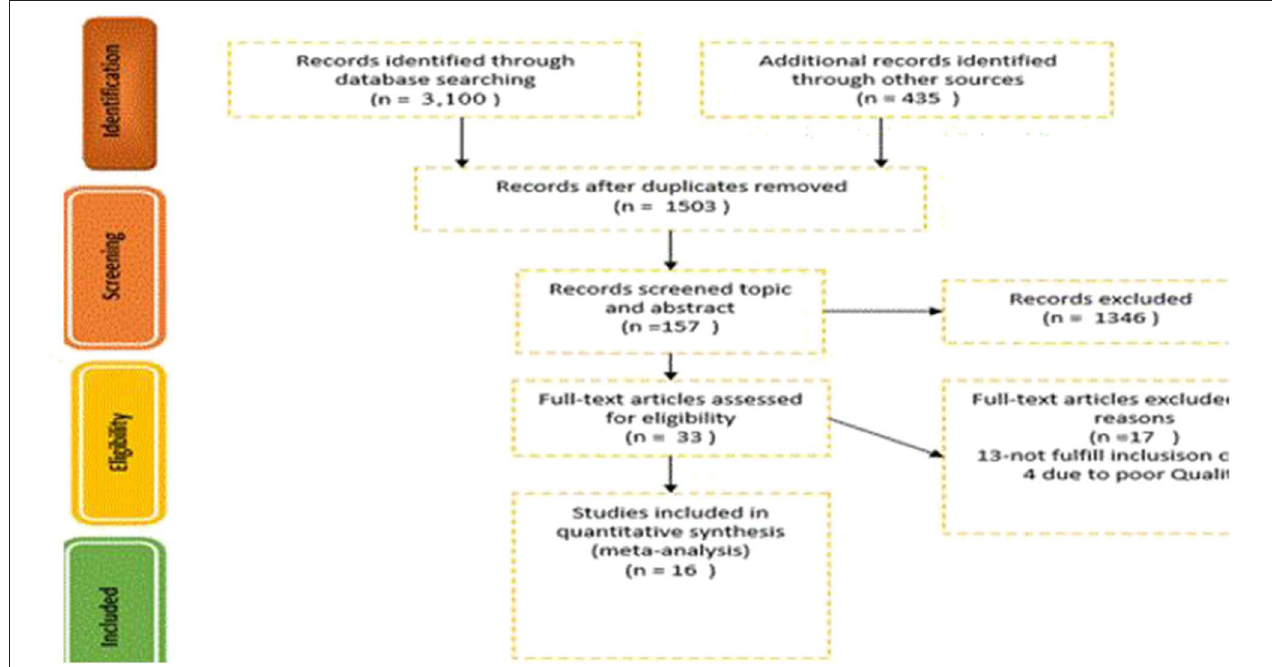
FIGURE 1 | PRISMA flow